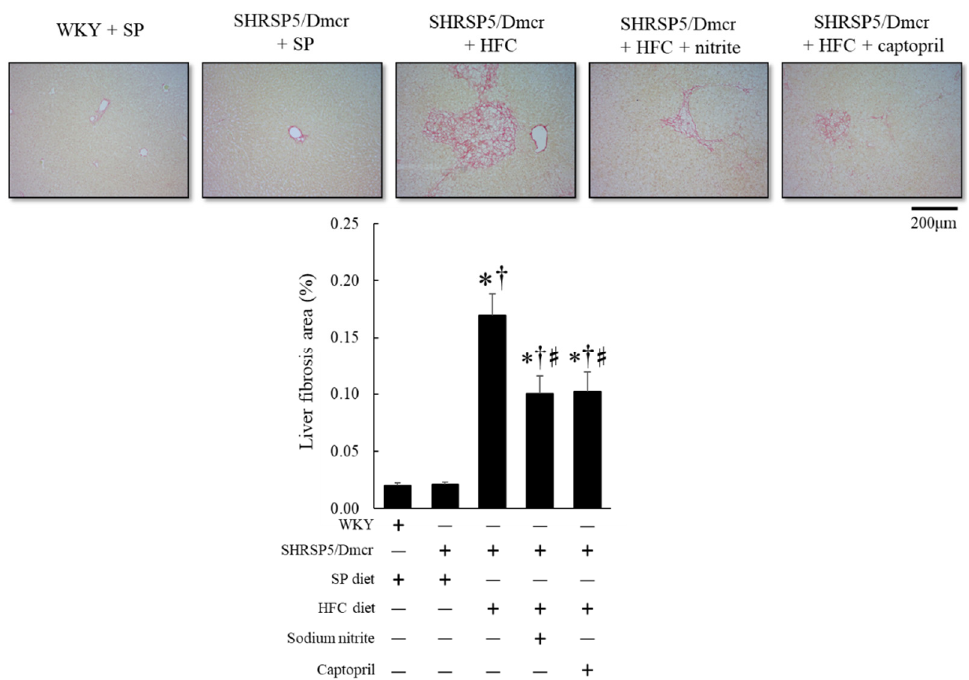
Figure 6. Histological analysis of liver fibrosis (Sirius Red stain) in the rat nonalcoholic steatohepatitis model treated with nitrite and captopril. Values represent mean ± SE ( n = 6), * p < 0.05 vs. WKY + SP diet group, † p < 0.05 vs. SHRSP5/Dmcr + SP diet group, ♯ p < 0.05 vs. SHRSP5/Dmcr + HFC diet group.